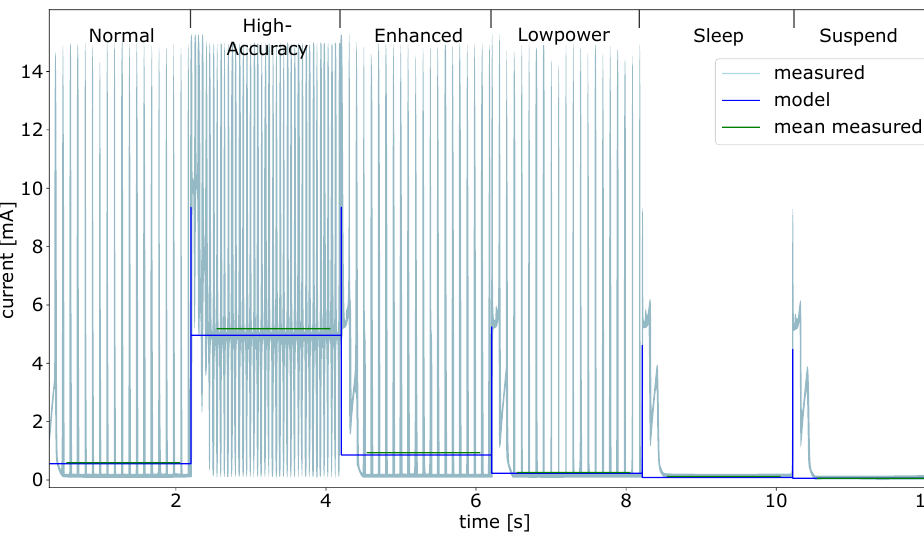
Figure 13. Magnetometer power modes model data and measured current